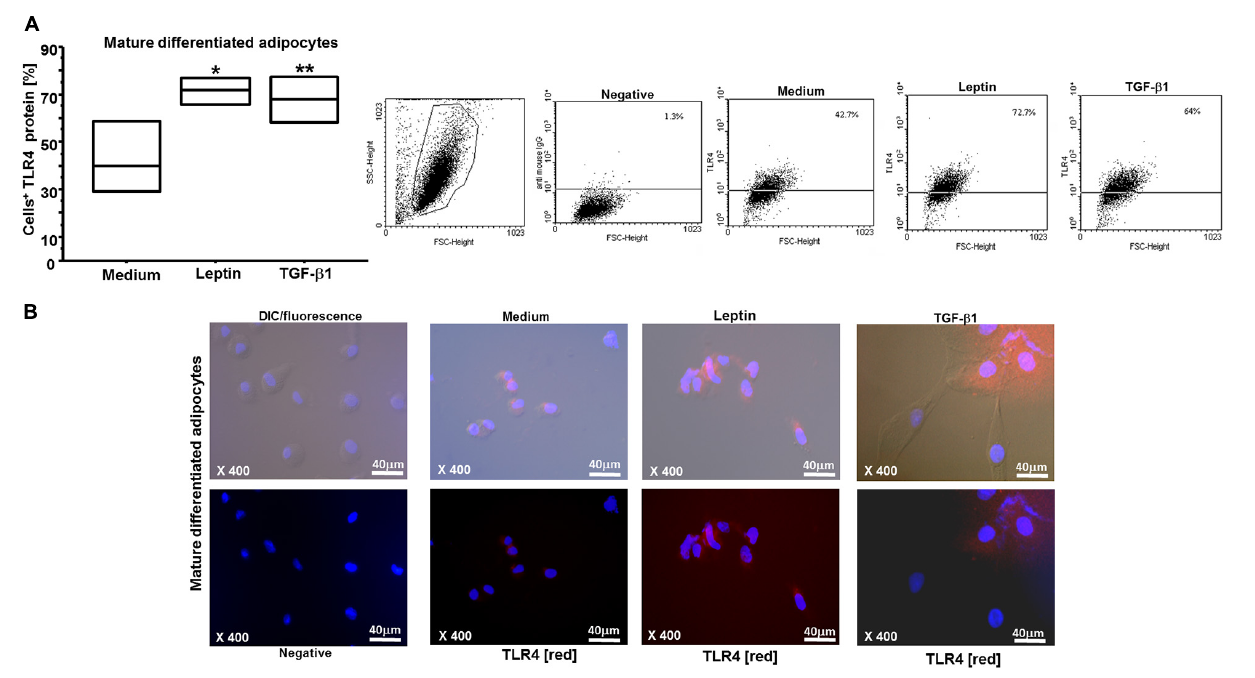
FIGURE 5 | (A) Flow cytometry analysis on mature differentiated adipocytes for TLR4: both leptin (0.05 µ M) and TGF- β 1 (400 nM) significantly increased TLR4 expression (* p = 0.0178 and ** p = 0.0325, respectively); the results are shown as box-plots with medians (lines inside the boxes) ( n = 4 experiments). Analysis of variance (ANOVA), Fisher’s PLSD. Right, representative examples of flow cytometric analysis. The numbers indicate the percentage of positive cells for TLR4. (B) Representative immunofluorescence for TLR4 (red) on mature differentiated adipocytes is shown: higher, differential interference contrast (DIC-Nomarski) combined with DAPI and fluorescence; lower, DAPI with fluorescence (magnification at × 400, scale bar = 40 µ m). Axioskop-2-Zeiss